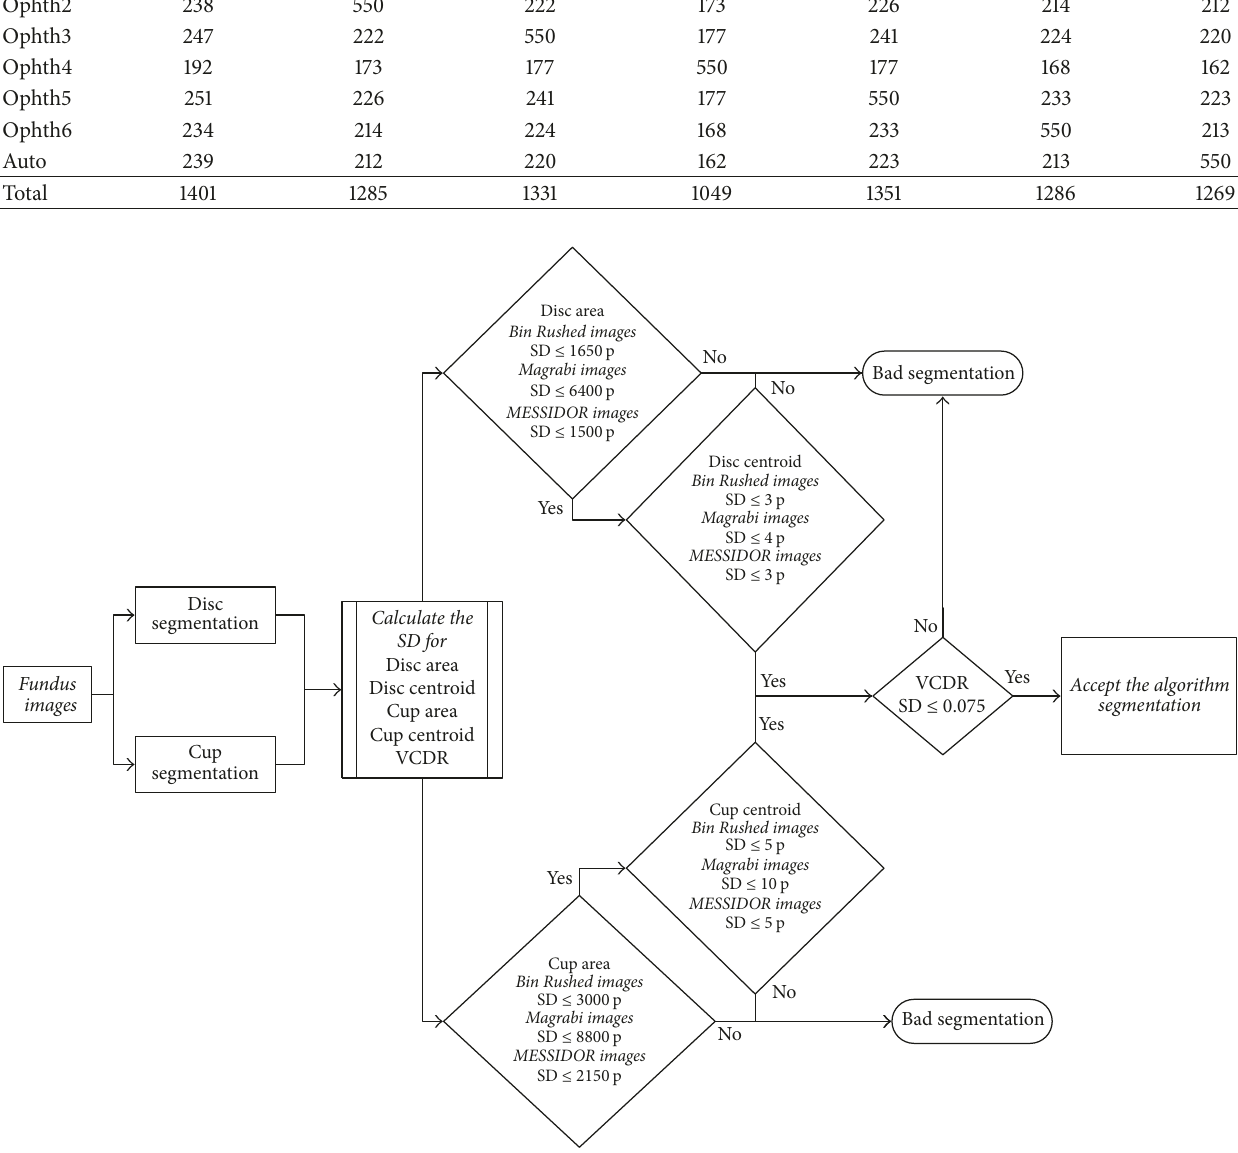
Figure 7: Flowchart of the analysis of VCDR